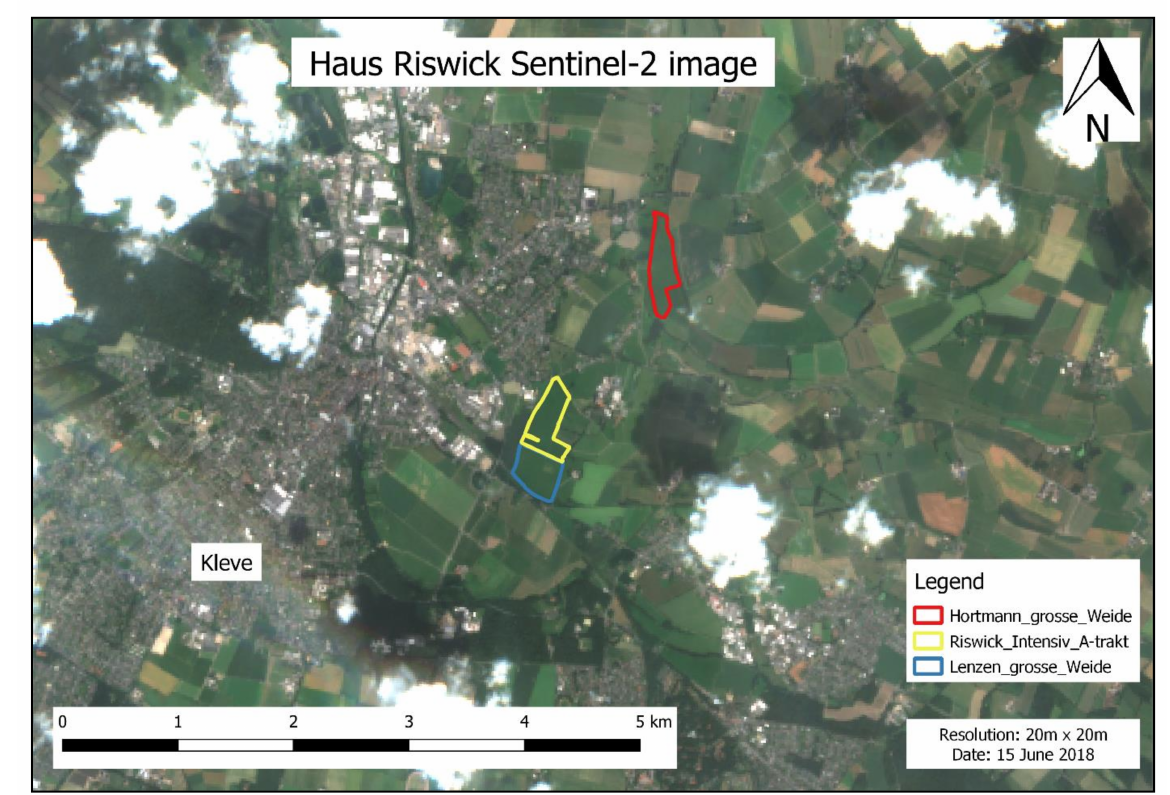
Figure 3. North Rhine-Westphalia (NRW)’s region where Haus Riswick is located (east of the city of Kleve). The orthophoto shows the three polygon objects of the evaluated experimental grassland parcels: Hortmann grosse Weide (most northern), Riswick Intensiv A-trakt (middle) and Lenzen grosse Weide (most southern).